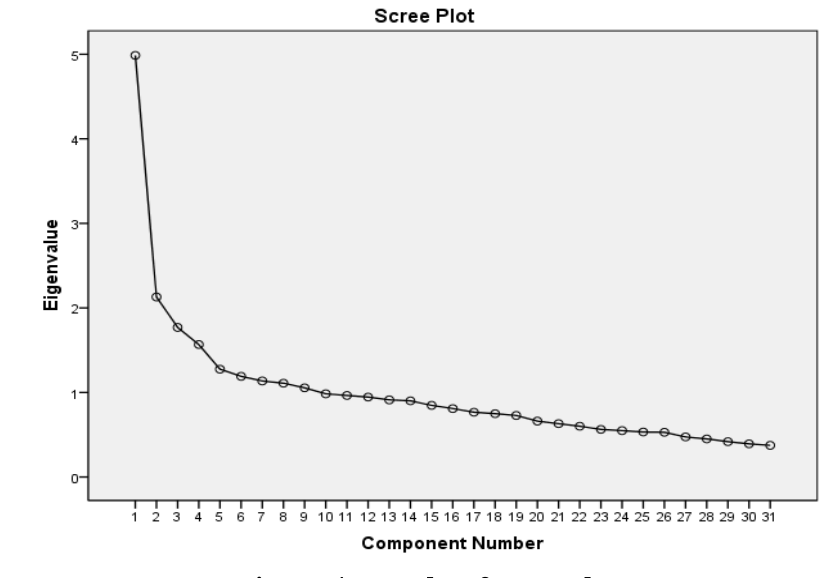
Fig. 1. The results of Scree